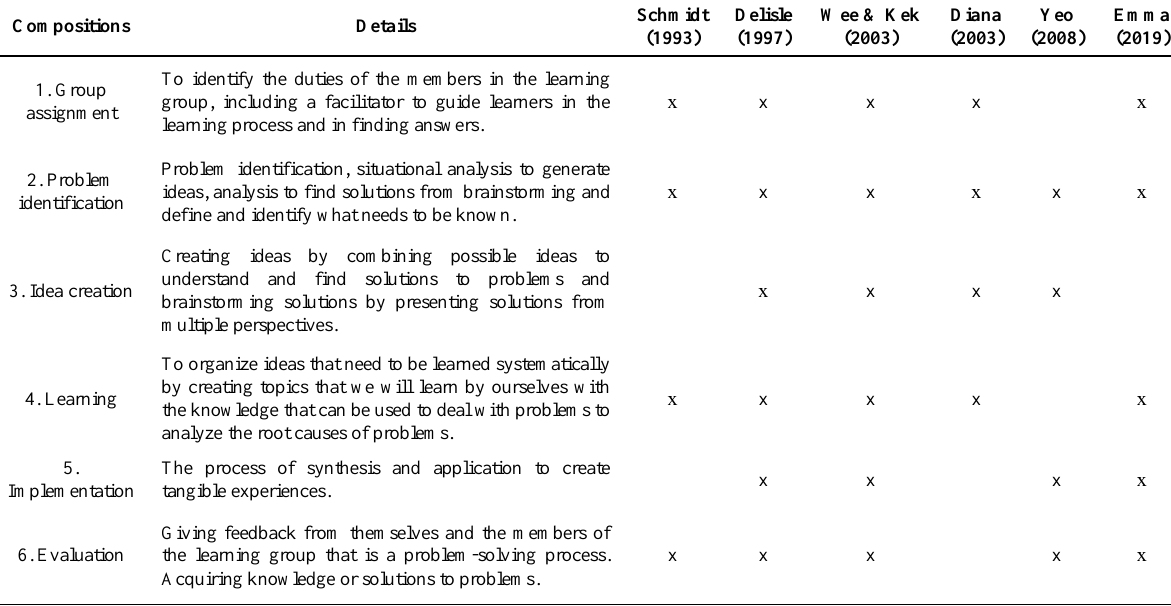
Table 1. The synthesis of the problem-based learning process in the workplace